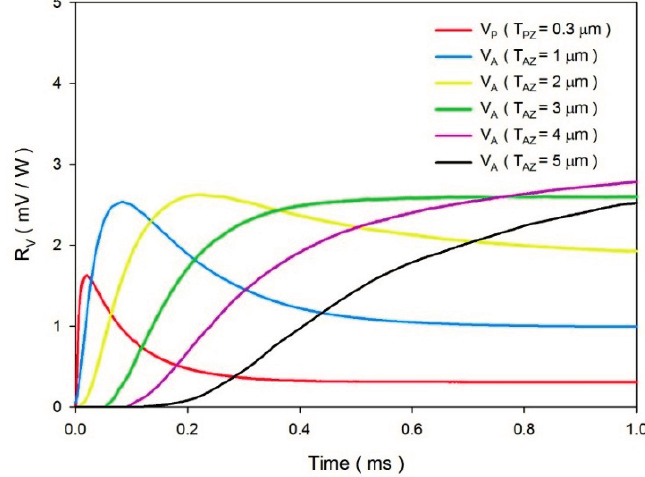
Figure 12. Relationship between the voltage responsivities and time in the multi-frequency band pyroelectric sensor under the sputtered ZnO film with a constant thickness of 0.3 μ m and the aerosol ZnO film with various thicknesses from 1 to 5 μ m.